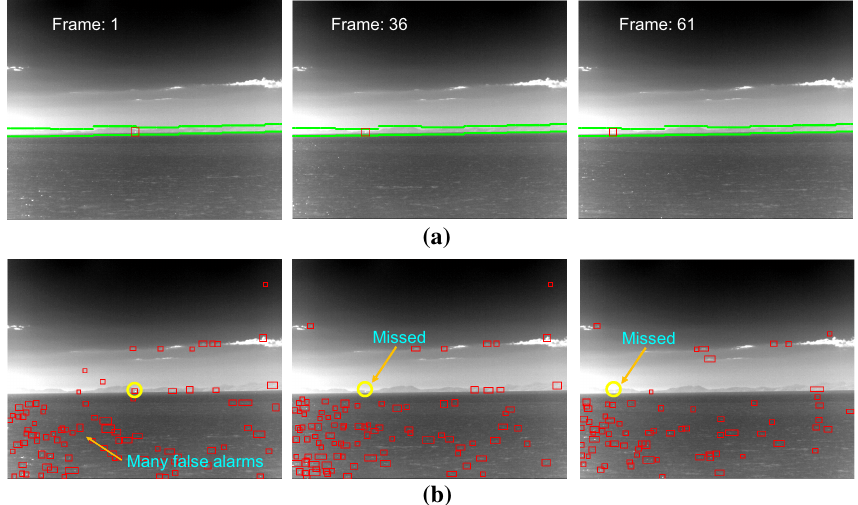
Figure 28. Effect of the coast region information in the infrared small target detection problem for the real WIG craft DB: ( a ) application of the temporal filter-based detector (TCF) for the identified coast region; ( b ) application of spatial filter-based detector (top-hat). The yellow circles denote the ground truths, and the red rectangles represent the detection results.